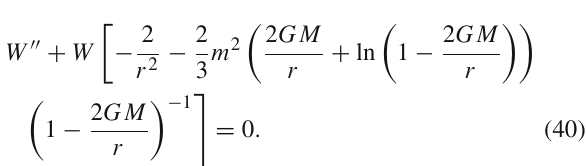
The constants α and β are fixed by initial conditions and they come out to be α ≈ 0 and β ≈ − 1 . 99625. For clear visibil- Eq. (43) and analytical solution (45) of Eq. (44) in Fig. 1